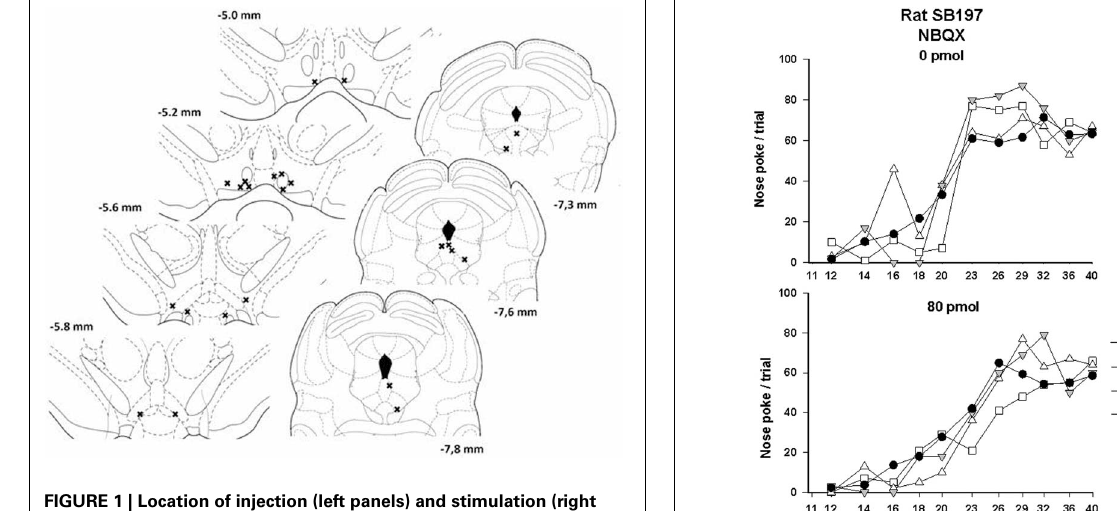
FIGURE 1 | Location of injection (left panels) and stimulation (right panels) sites for each animal included in the study. Each site is represented by a single cross. Illustrations are modified drawings from Paxinos and Watson’s atlas (1986); the number on the side of each plate represents the anterior-posterior distance (mm) from bregma.